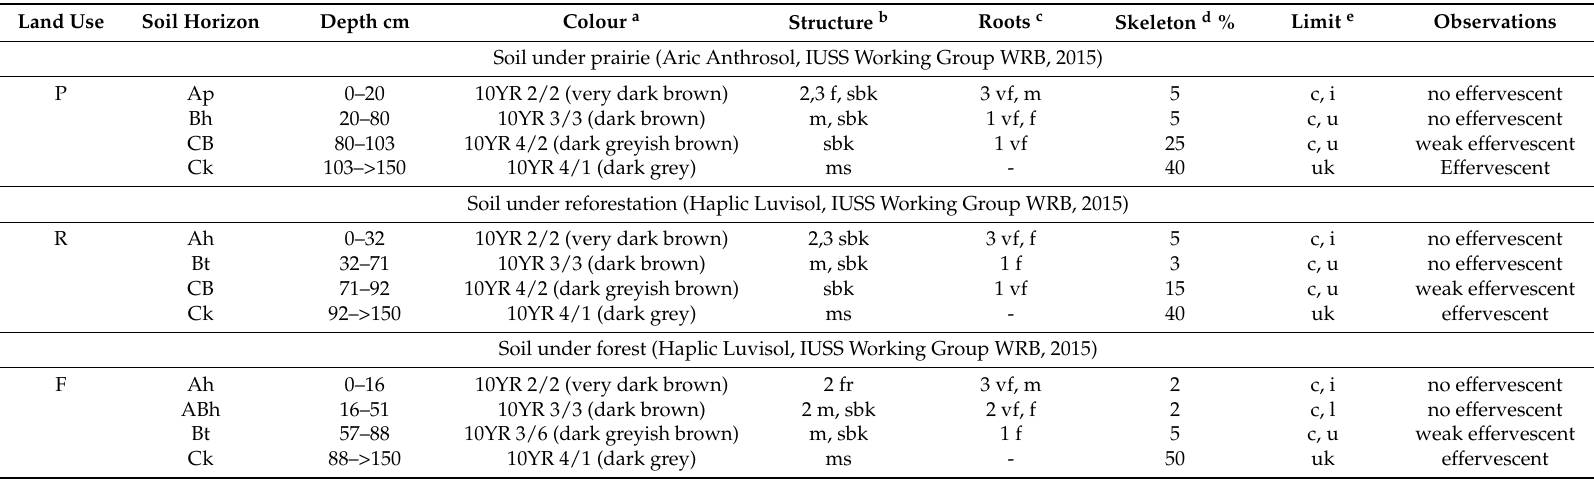
Table 1. Morphological description of the three representative profiles belonging to the three land use types (prairie, P; reforestation, R; forest, F), Cortina d’Ampezzo Valley,